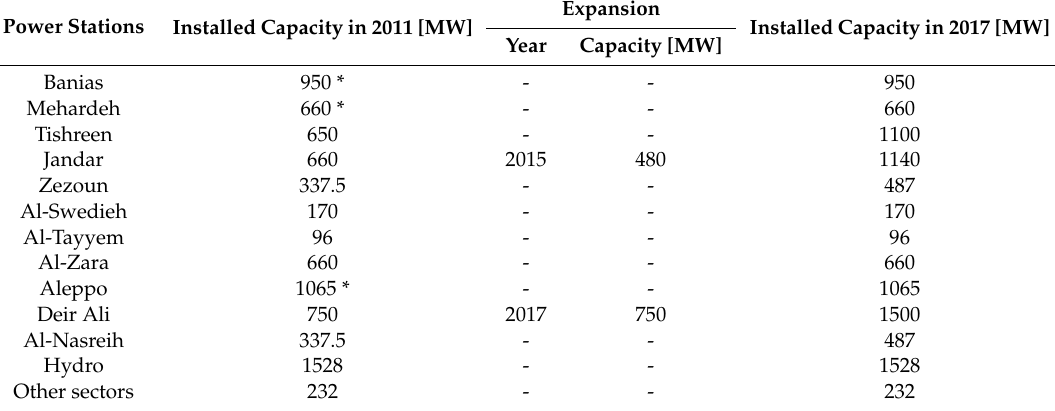
Table 5. Installed capacity in 2011, a year of expansion, and the expansion capacity of the SEPS’s generation stations until